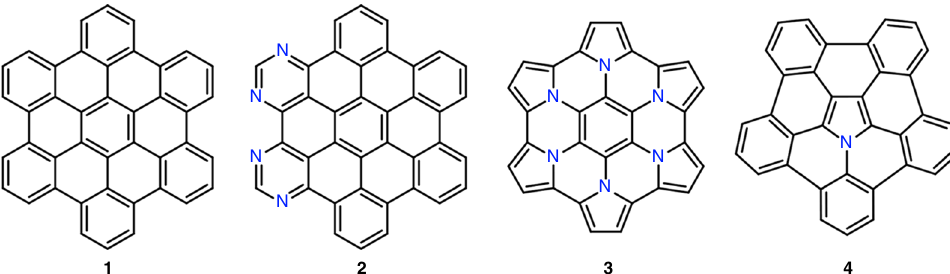
Fig. 1 Chemical structures of pristine and N-doped nanographenes. Hexa- peri -hexabenzocoronene (HBC) 1 , periphery-doped tetraaza-HBC 2 , azacoronene derivatives 3 , and azacorannulene 4